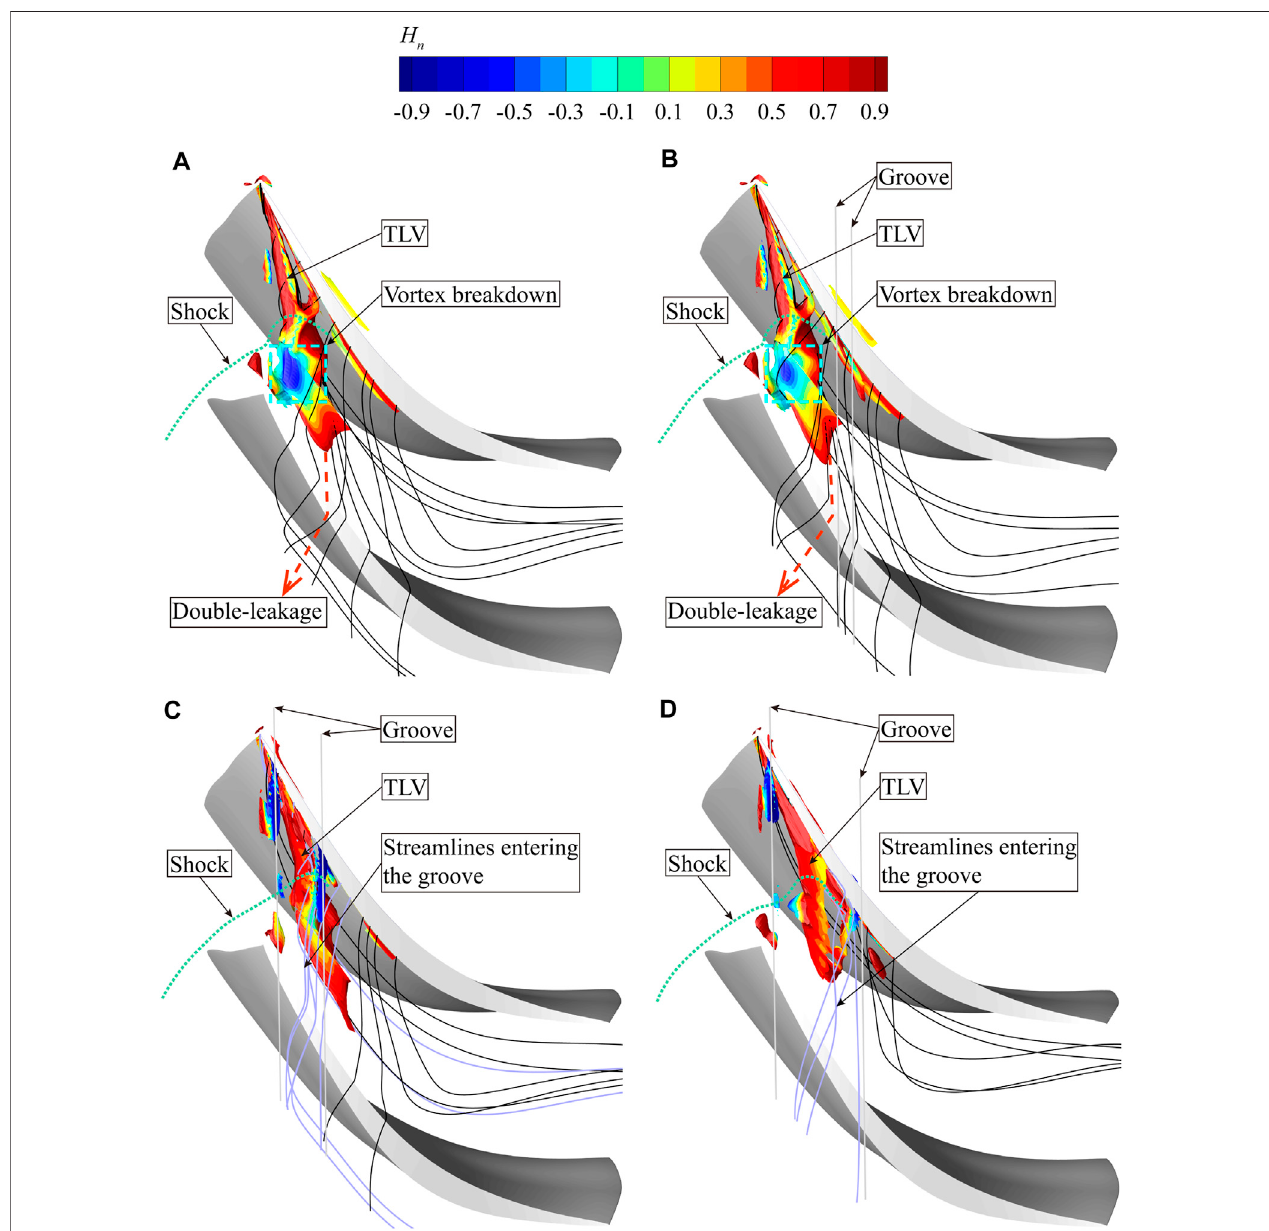
FIGURE7| Tip vortexstructureswithand without casingtreatmentat NS,captured by Ω method. (A) Smoothcasing (B) MaxPEI point (C) TOPSIS point (D) Max SMI point.